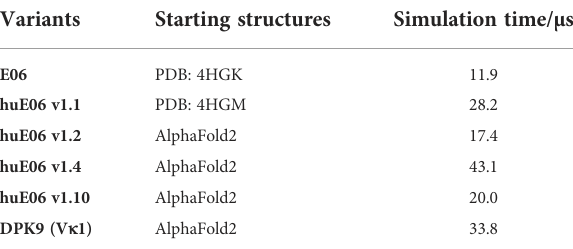
TABLE 1 Overview of the investigated variants with the aggregated simulation times.